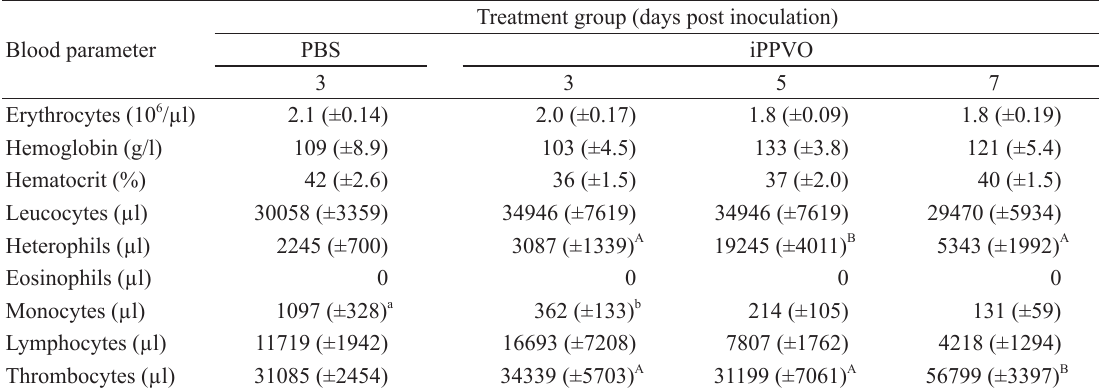
Hematological parameters of silver catfish inoculated with phosphate buffered saline (PBS) or inactivated Parapoxvirus ovis (iPPVO). Blood samples were collected from all inoculated fish (n = 15) at the indicated time. Data represent the mean ±S.E.M. Differences between the PBS and iPPVO group at 3 days post inoculation are indicated by small letters and differences (p < 0.05) within the iPPVO group at each time point are indicated by capital letters.